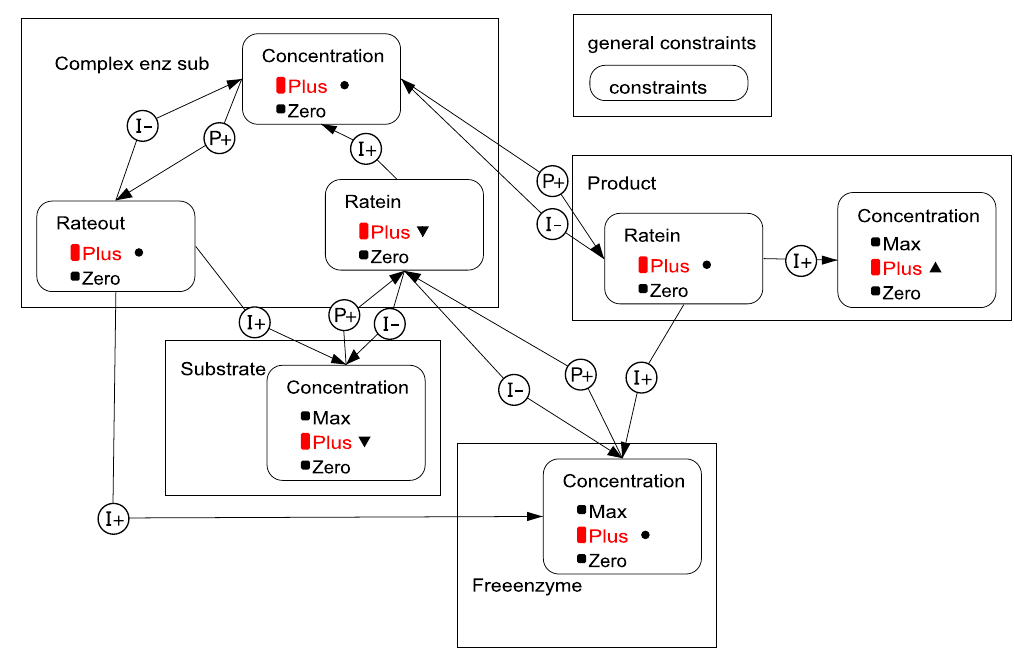
Figure 5. Causal dependencies compiled by Garp3 for state 4 (cf. Fig. 3). The graph provides a causal account for what is depicted by the value history (Fig. 4). Large squares refer to entities (system components). Rounded squares refer to quantities. Current quantity values are coloured red, but can also be identified from the adjacent derivative